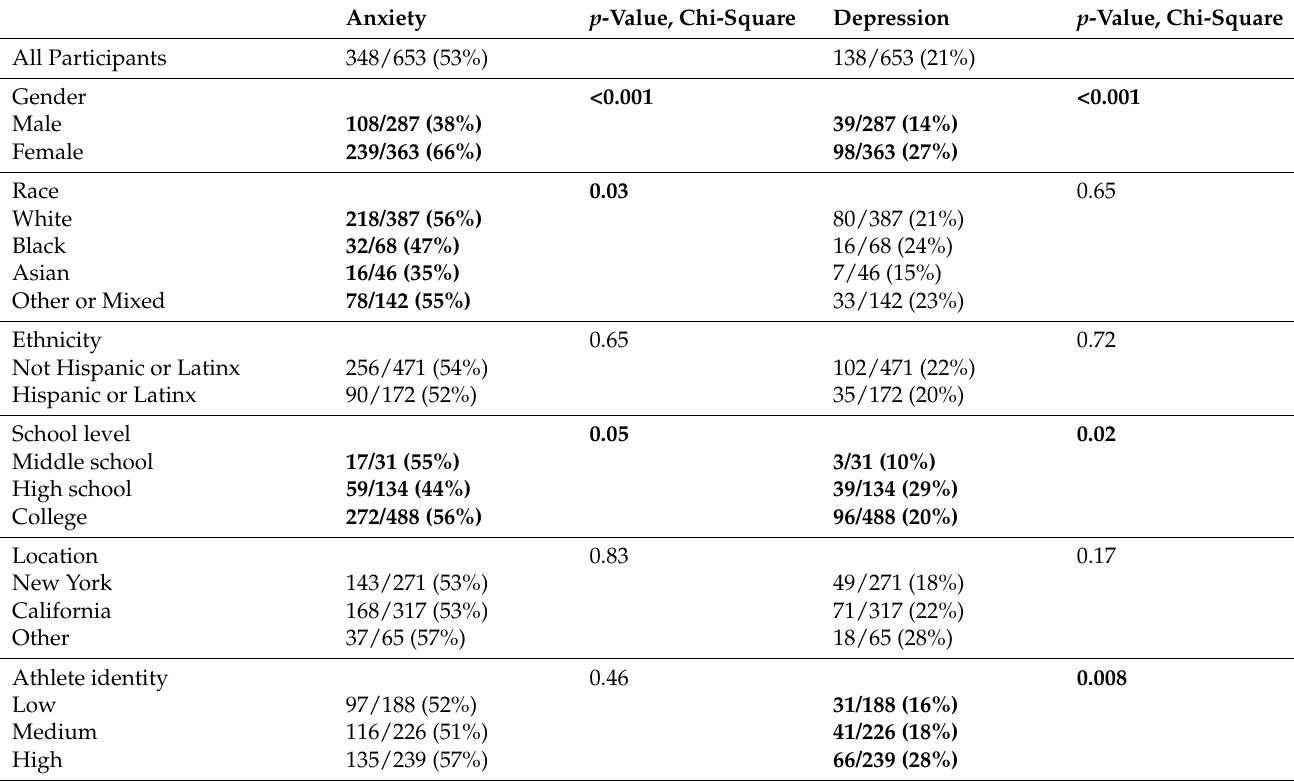
Table 4. Frequency of symptoms of anxiety and depression by demographic